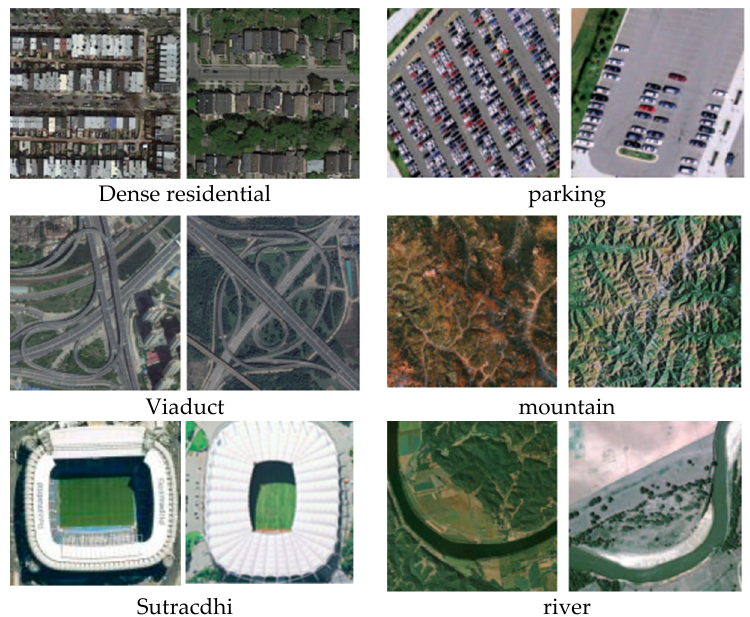
Figure 9. Sample images of the two datasets. First two Columns: AID Database. Second two Col- umns: NWPU-RESISC45 Dataset. Columns: NWPU-RESISC45